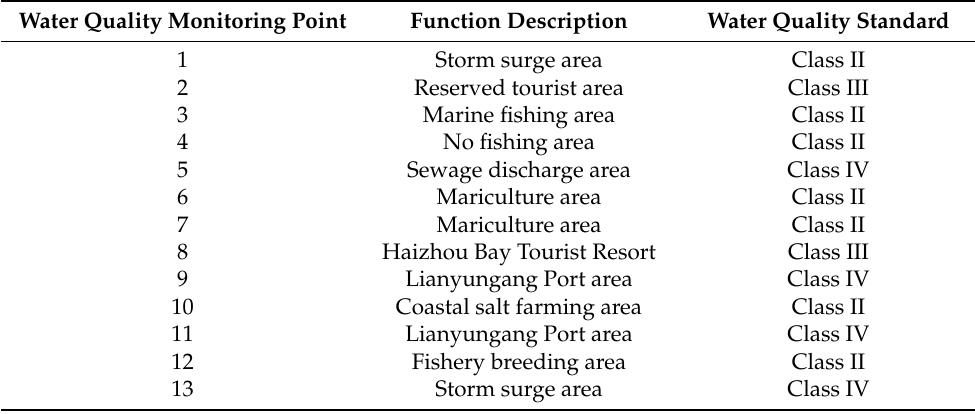
Table 2. Water quality target at monitoring